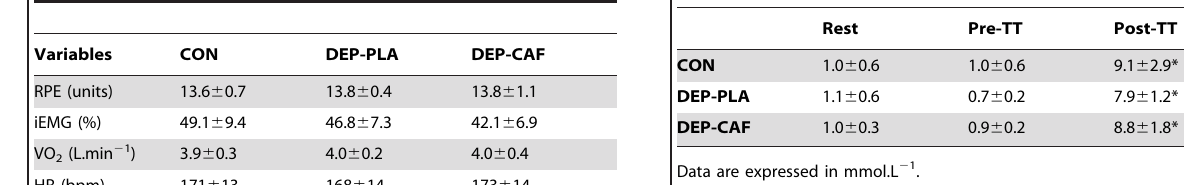
Table 2. Mean and SD for rating of perceived exertion (RPE), integrated electromyography (iEMG), average oxygen uptake (VO 2 ) and heart rate (HR) during the 4-km cycling TT.